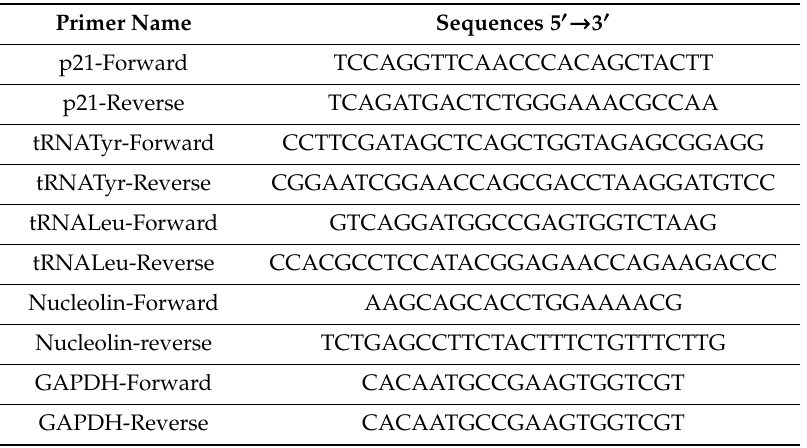
Table 1. Oligonucleotide